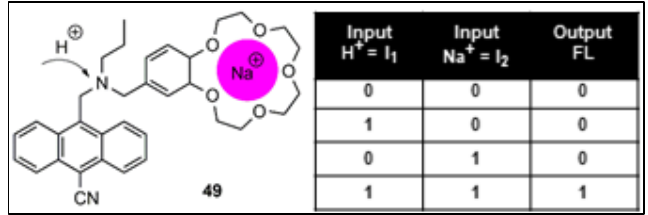
Figure 47 . Chemical system 49 performs AND logic operation under the action of two chemical inputs (H + and Na + ) and the corresponding truth table [150].